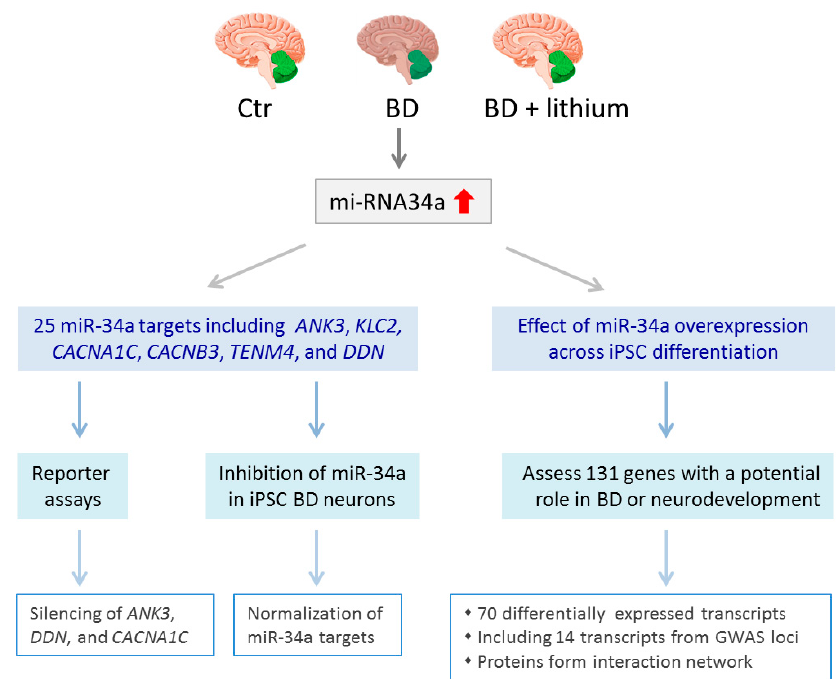
Figure 3. miRNA-34a in bipolar disease. miRNA-34a expression levels were selectively increased in the cerebellum from bipolar disease (BD) patients when compared to controls (Ctr) or patients that had received lithium treatment. Bioinformatic analysis predicted 25 miR-34a target genes including the GWAS loci ANK3 , KLC2 , CACNA1C , CACNB3 , TENM4 , and DDN . Transient reporter assays showed that miR-34a overexpression does silence ANK3 , CACNA1C , and DDN expression. Conversely, inhibition of elevated miR-34a in neurons derived from BD iPSCs led to normalization of miR-34a target genes. In an orthogonal approach, Bavamian et al. [67] investigated the effects of miR-34a overexpression across iPSC differentiation on a panel of 131 genes with a potential role in BD or neurodevelopment. Among 70 differentially expressed transcripts, fourteen were encoded by GWAS loci. Furthermore, the corresponding proteins of these risk loci formed a highly connected protein interaction network.